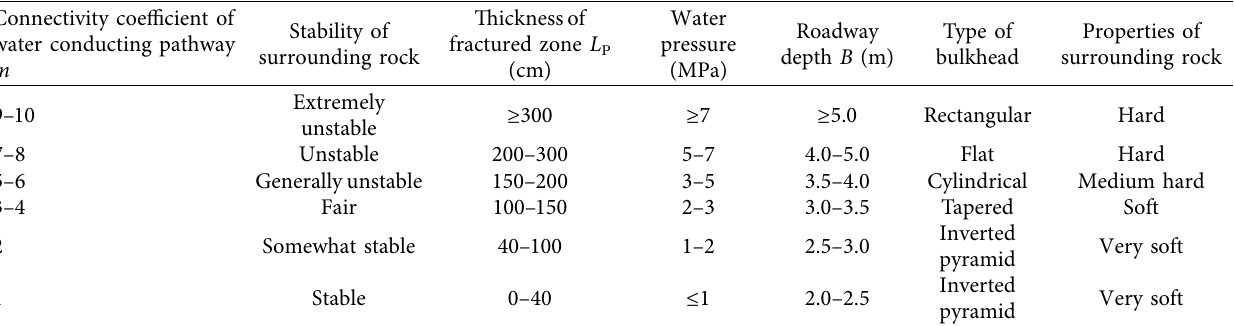
Table 6: Connectivity coefficients of water conducting pathway in fractured zone around mine opening in surrounding rock. Connectivity coefficient of water conducting pathway